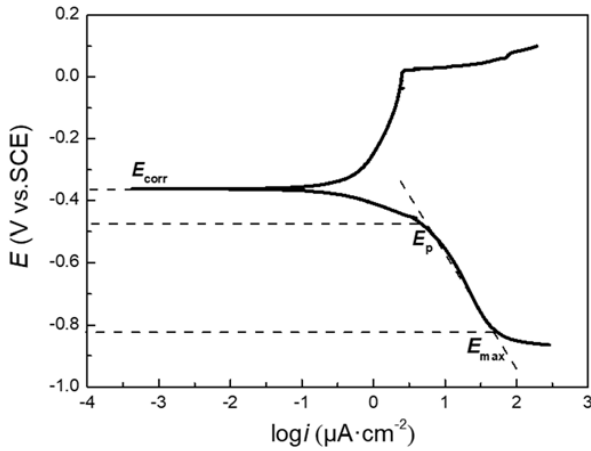
Figure 1. Potentiodynamic polarization curve of 304 stainless steel (SS) in seawater.